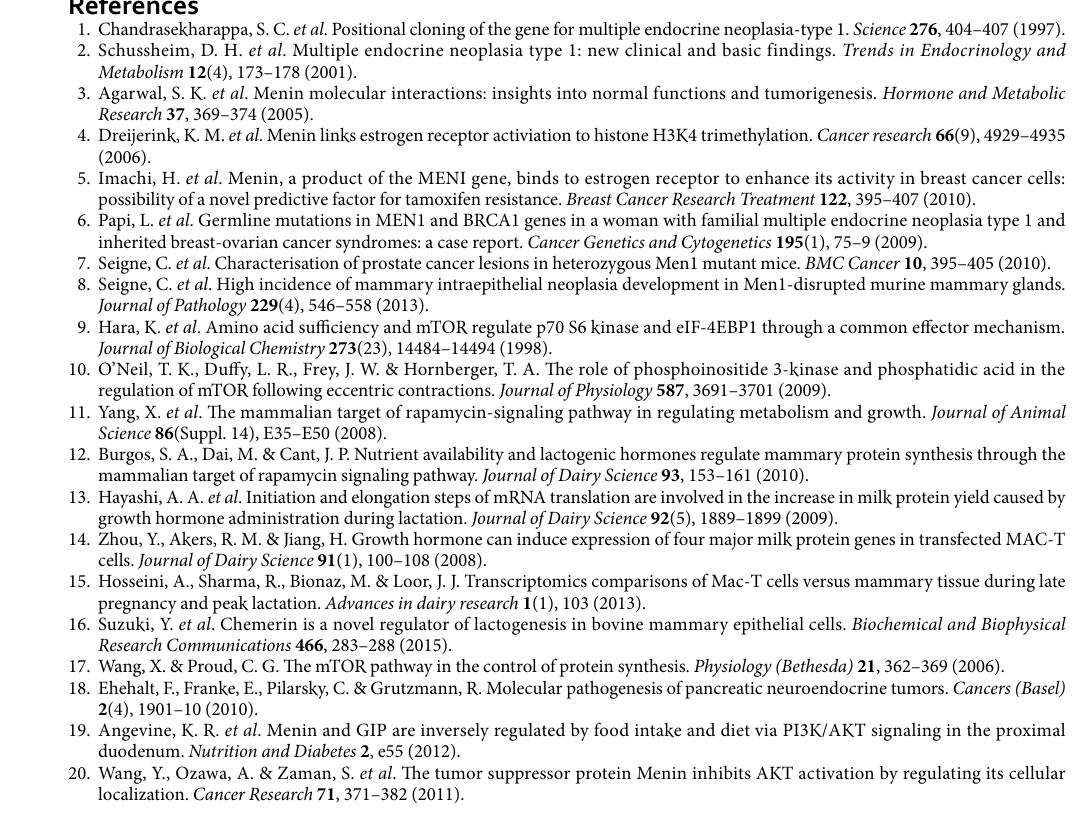
Table S2. Cows were housed in a free stall barn with constant access to water and feed. Diets were formulated to meet all NRC (2001) recommendations for mid-lactation and dry cows using the Cornell-Penn-Miner system (CPM-Dairy, version 3.0.7). Feed was provided ad libitum , and the cows were milked three times daily. Statistical